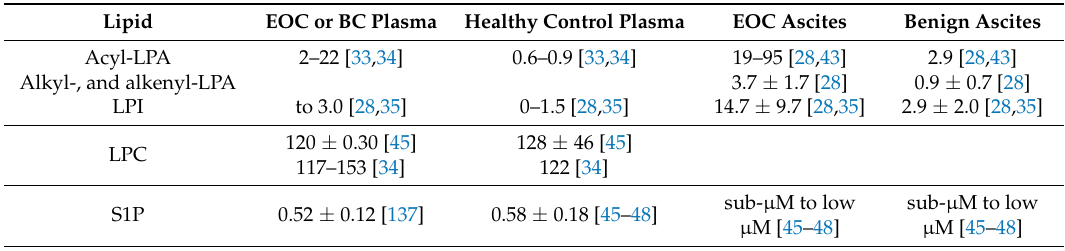
Table 1. Concentrations (in µ M) of major lysophospholipids (LPLs) involved in epithelial ovarian cancer